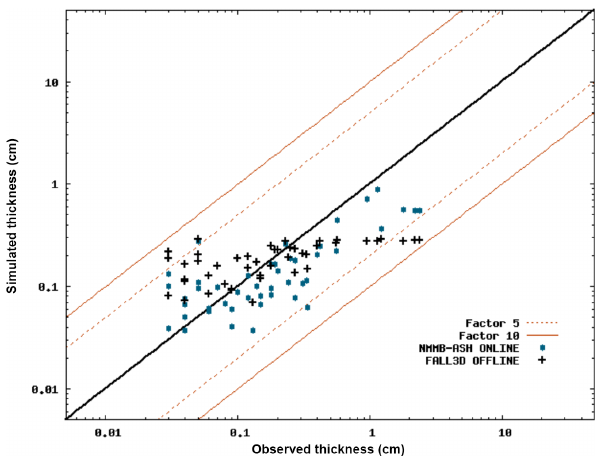
Figure 10. Simulated versus observed thicknesses for the recon- struction of the 2001 Etna eruption with NMMB-MONARCH-ASH (circles) and FALL3D (crosses). The solid bold line represents a perfect agreement, while the dashed and solid thin orange lines mark the region that is different from observed thicknesses by a factor of 5 (1 / 5) and 10 (1 / 10),